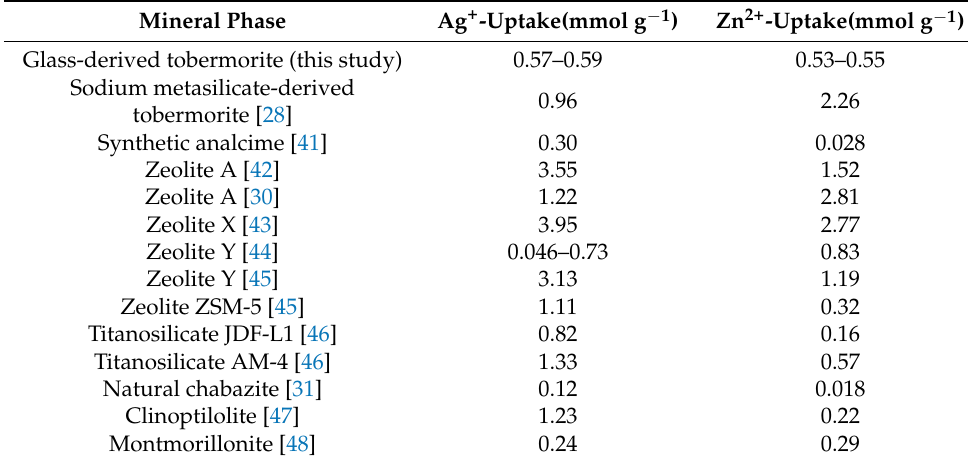
Table 3. Uptake of Ag + and Zn 2+ ions by various silicate lattice and framework phases. Mineral Phase Ag + -Uptake(mmol g − 1 ) Zn 2+ -Uptake(mmol g − 1 ) Glass-derived tobermorite (this study) 0.57–0.59 0.53–0.55 Sodium metasilicate-derived 0.96 2.26 tobermorite [28] Synthetic analcime [41] 0.30 0.028 Zeolite A [42] 3.55 1.52 Zeolite A [30] 1.22 2.81 Zeolite X [43] 3.95 2.77 Zeolite Y [44] 0.046–0.73 0.83 Zeolite Y [45] 3.13 1.19 Zeolite ZSM-5 [45] 1.11 0.32 Titanosilicate JDF-L1 [46] 0.82 0.16 Titanosilicate AM-4 [46] 1.33 0.57 Natural chabazite [31] 0.12 0.018 Clinoptilolite [47] 1.23 0.22 Montmorillonite [48] 0.24